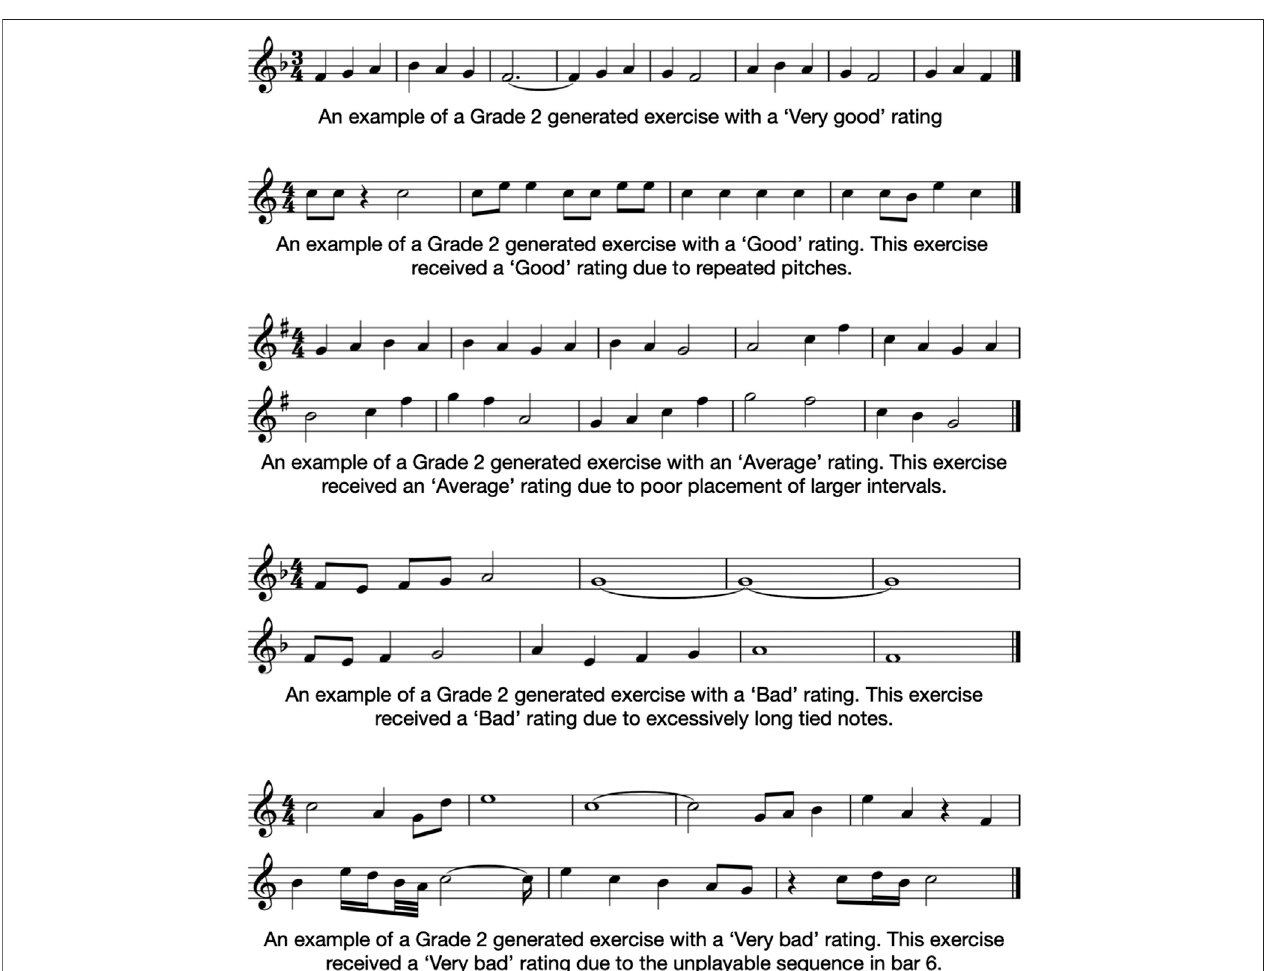
FIGURE7| ExamplesofGrade 2generatedexercisesassigned each oftheLikert quality ratings. Notethatthe “ Very bad ” examplewasgiventhisratingdue tothe rhythm in bar 6 being uncharacteristically dif fi cult for the Grade 2 dif fi culty level.